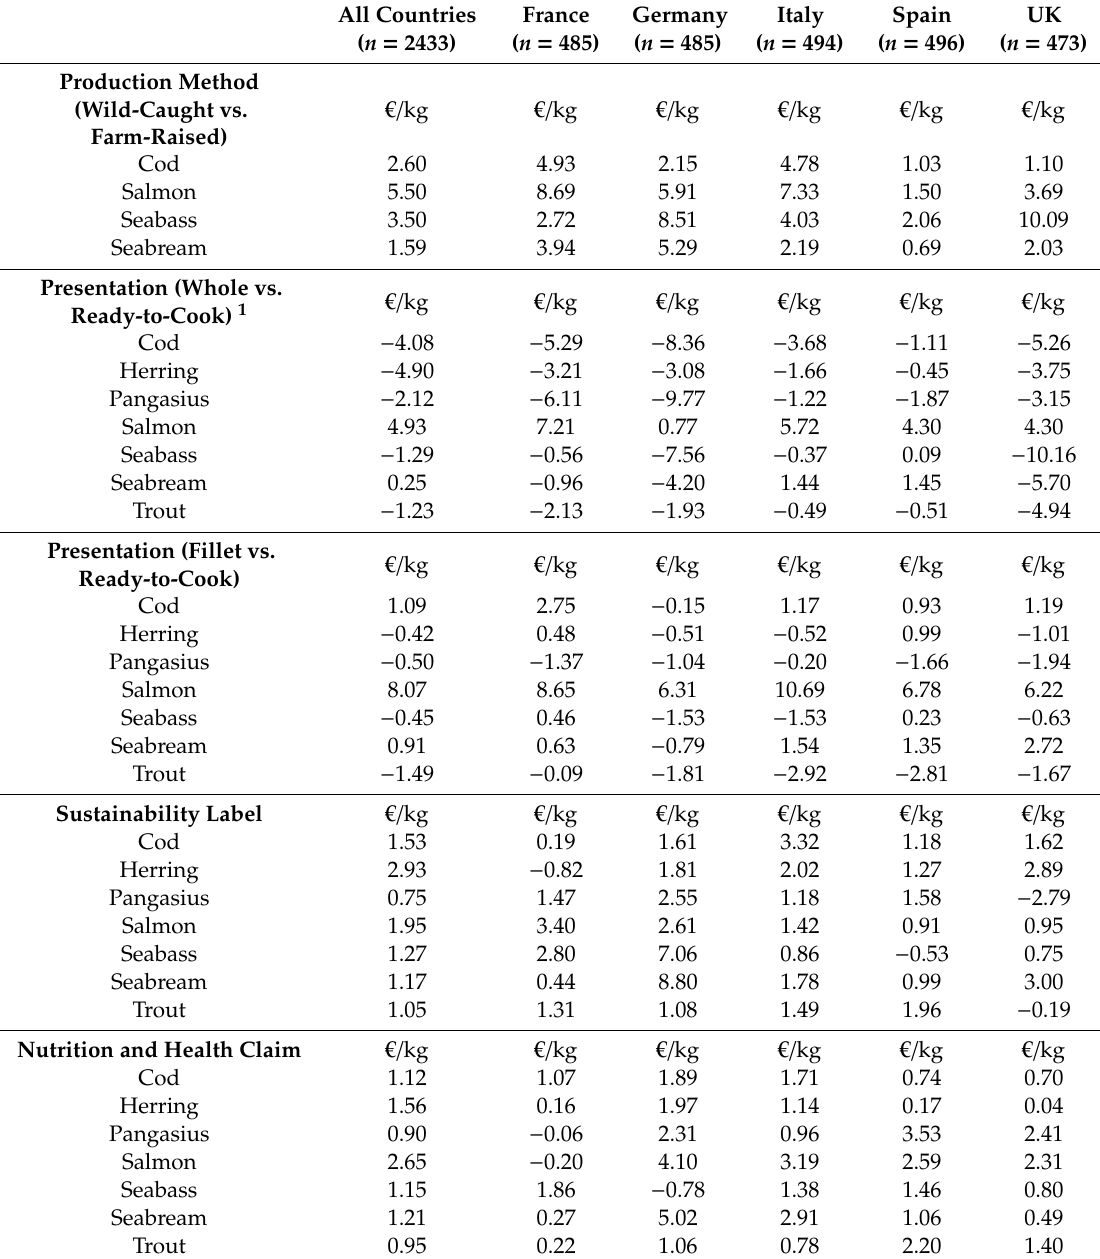
Table A4. Willingness to pay (WTP) estimates (mean values, € / kg) of the Fish Species-Specific E ff ect (FSSE) model per